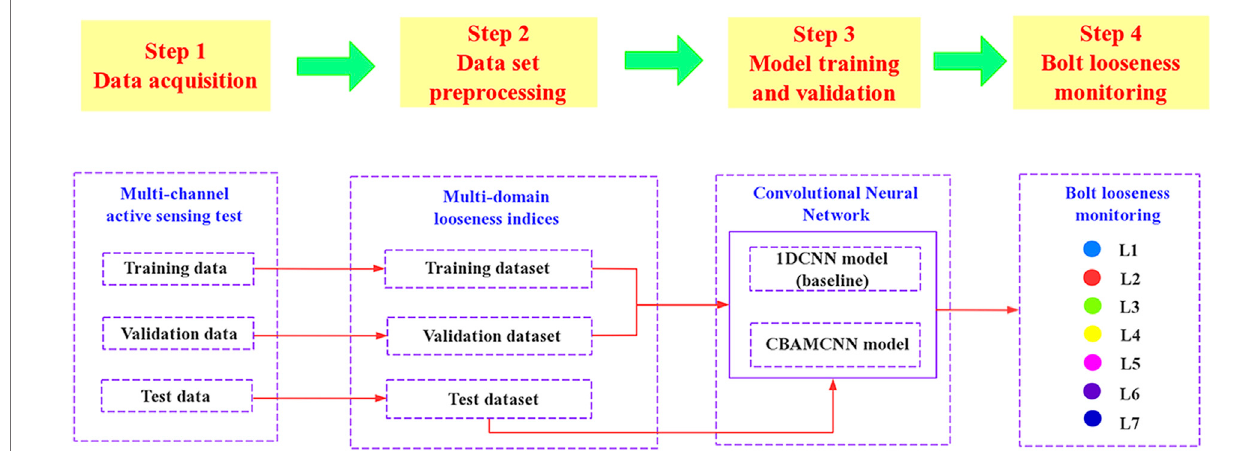
FIGURE 1 | Quantitative monitoring method of bolt looseness.